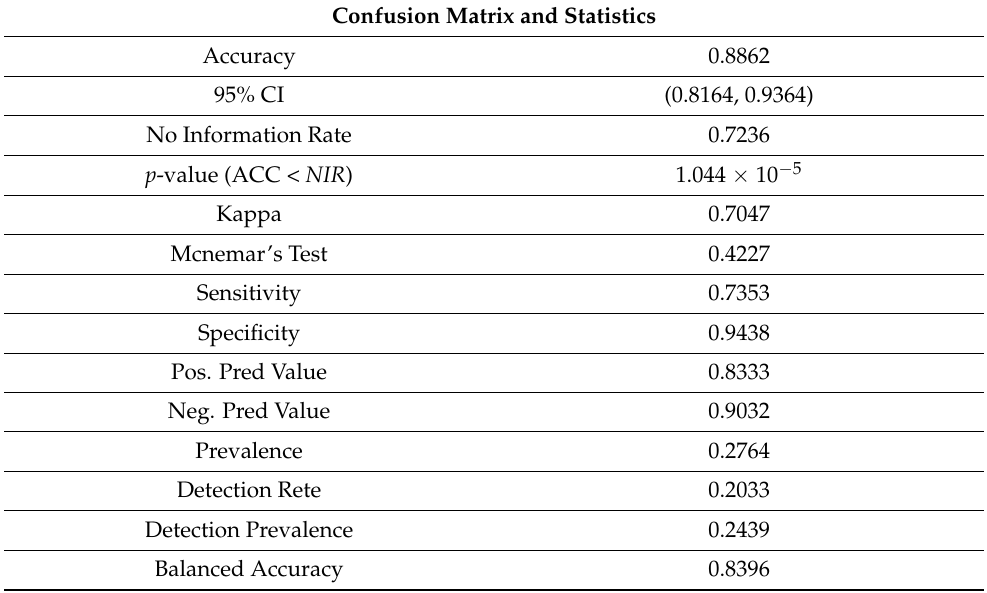
Table 3. Confusion matrix used for the classification of forest cutting on the analyzed plots in the study